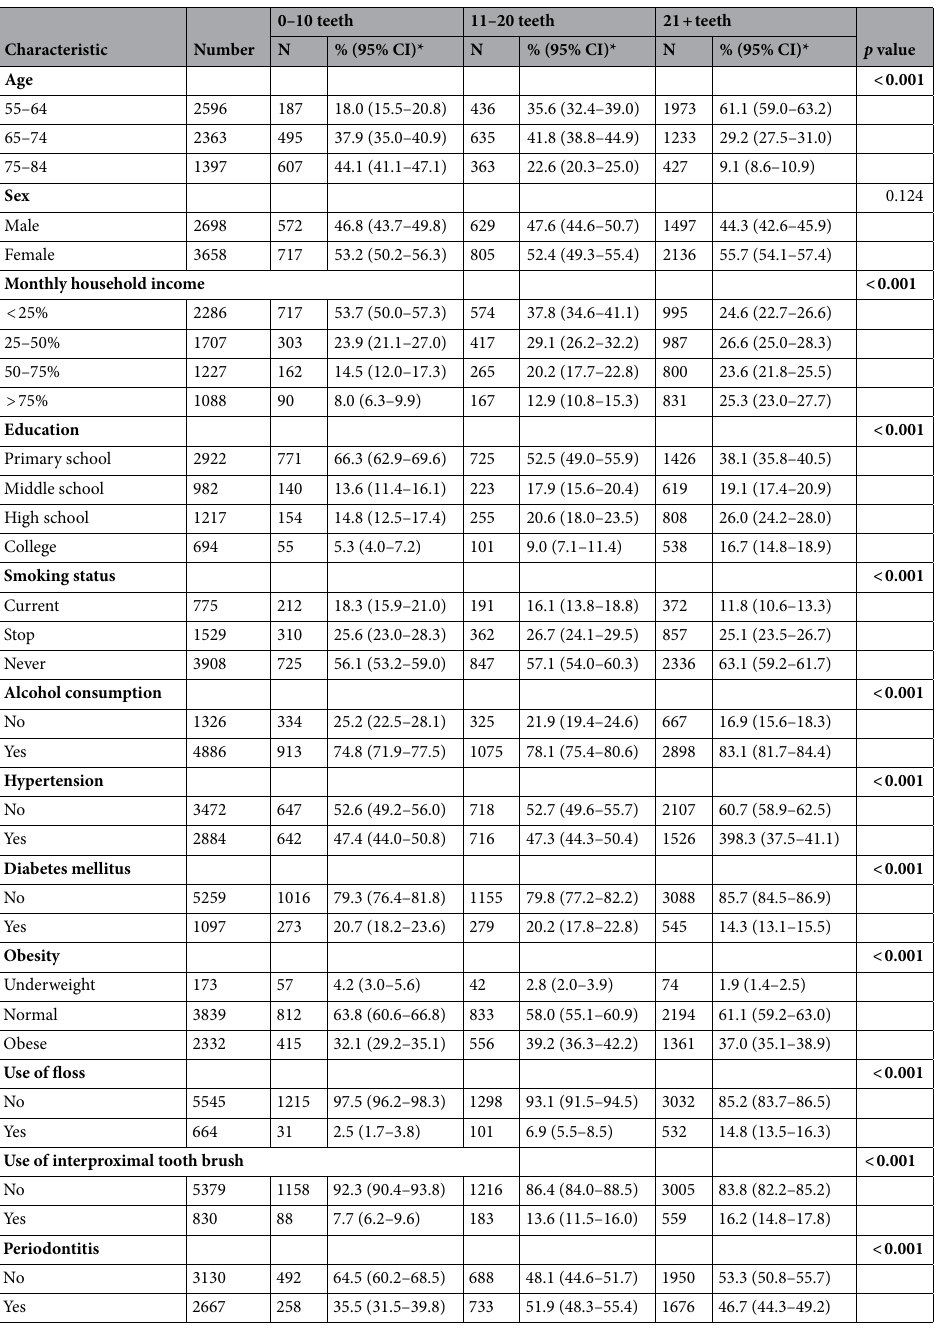
Table 1. Characteristics of the participants according to number of teeth group (N = 6356). Values are presented as number (%). Monthly Household income: monthly average family equivalent income (-monthly average household income/√(the number of household members). Obesity; Normal; Body Mass Index (BMI) 18.5 to < 25, Underweight: BMI < 18.5, and Obesity: BMI ≥ 25.0 kg/m 2 . Periodontitis was defined as community periodontal index 3–4. *Weighted percent, 95% Confidence Interval (CI), and p-value obtained by Chi-square